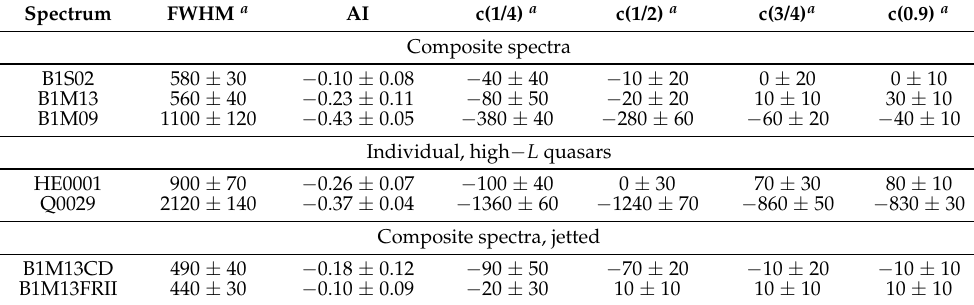
Table 5. [O III ] λ 5007 profile measurement.